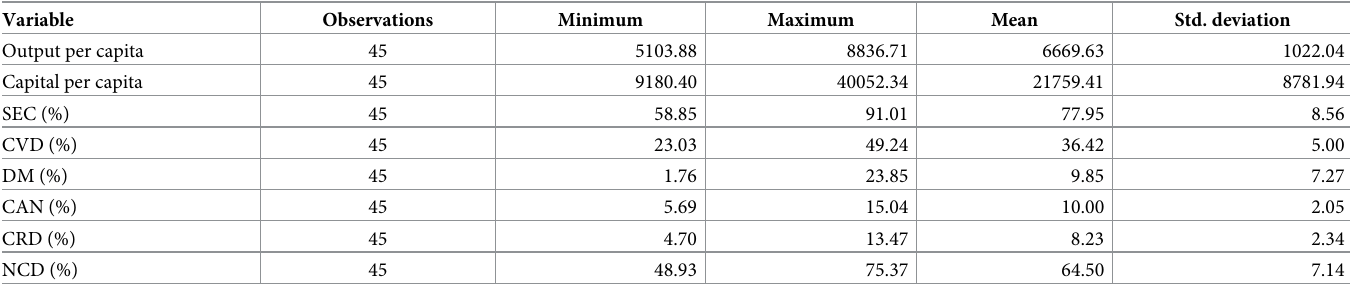
Table 2. Summary statistics from